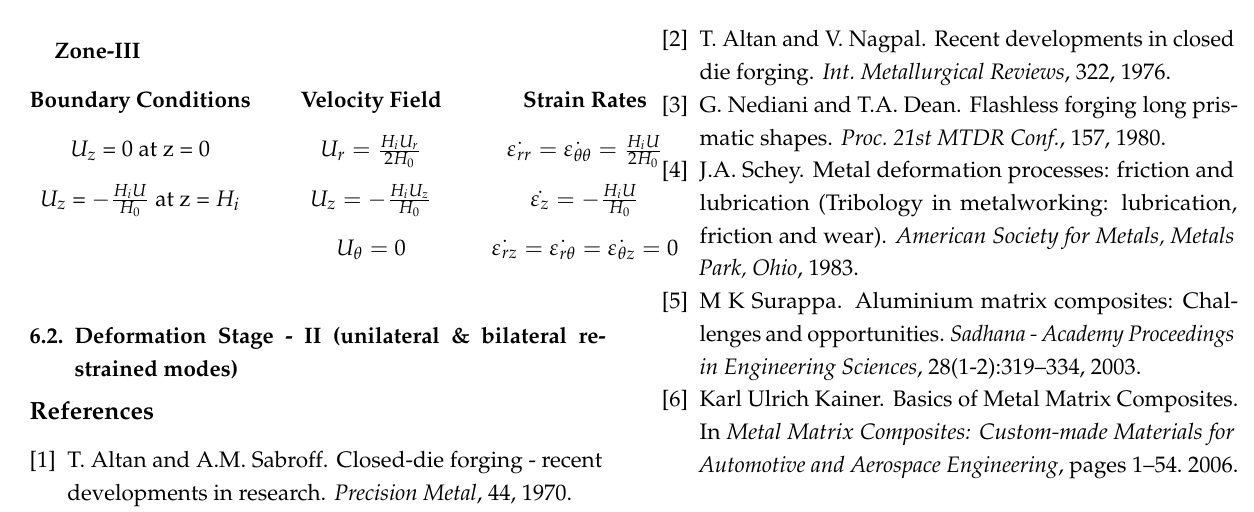
Fig. 11. Variation of Die Load with Die